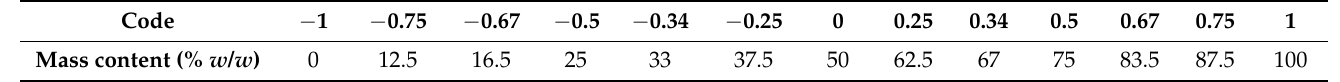
Table 1. Levels of the 13 runs and their corresponding mass contents.